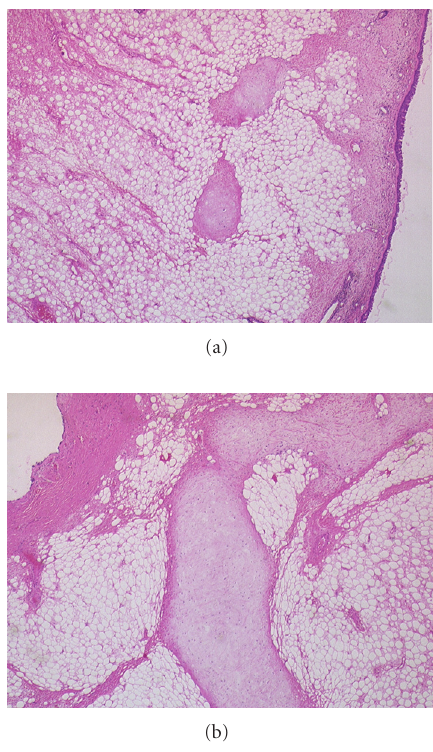
Figure 3: The images above are both at × 20 magnification. The view in Figure 3(a) shows a predominance of mature adipose tissue with fine bands of fibrosis and round islands of cartilage. The surface ciliated columnar epithelium is to be seen on the right of this image along with an island of cartilage. The chondrocytes lack cytological atypia or mitotic activity. Figure 3(b) shows an island of cartilage at higher